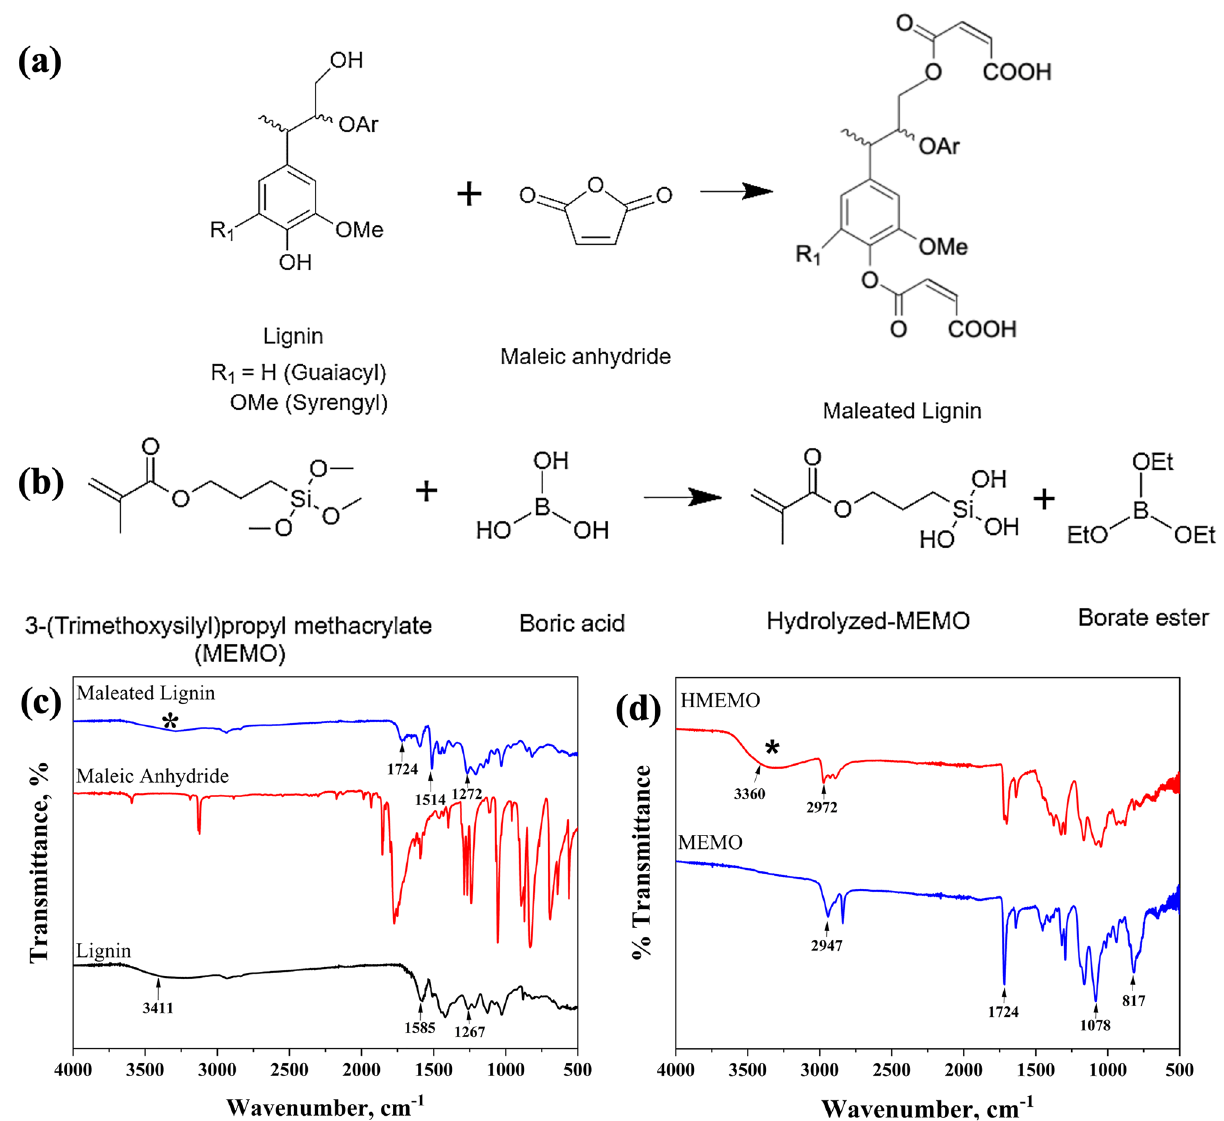
Figure 1. Reaction schemes of ( a ) lignin modification and ( b ) MEMO hydrolysis; FT-IR spectras of ( c ) pure lignin, maleic anhydride, and maleated lignin, ( d ) MEMO and hydrolyzed